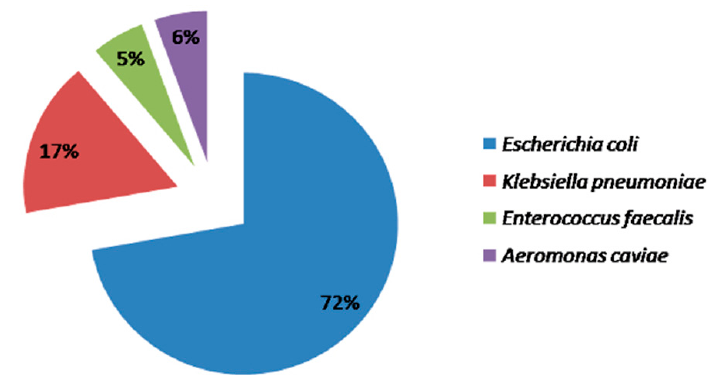
Figure 1. Percentage of isolated UTI pathogens.